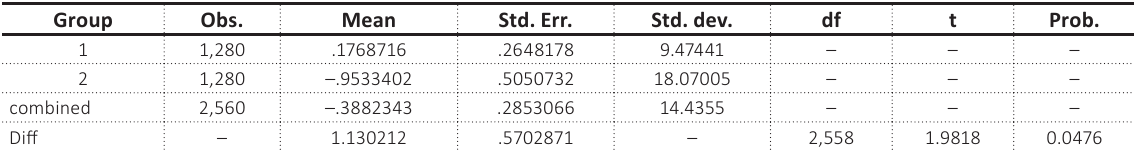
Source: Processed dataset by the authors.